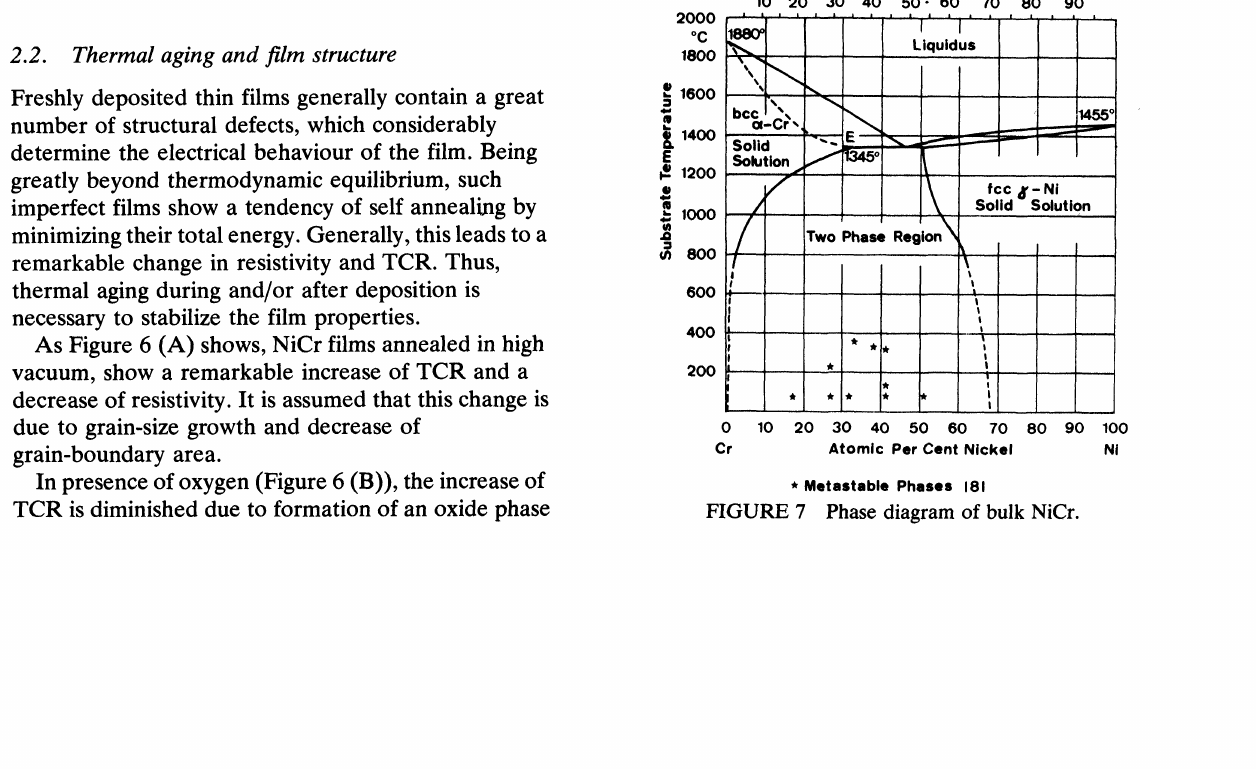
pressure and stabilization 2 partial